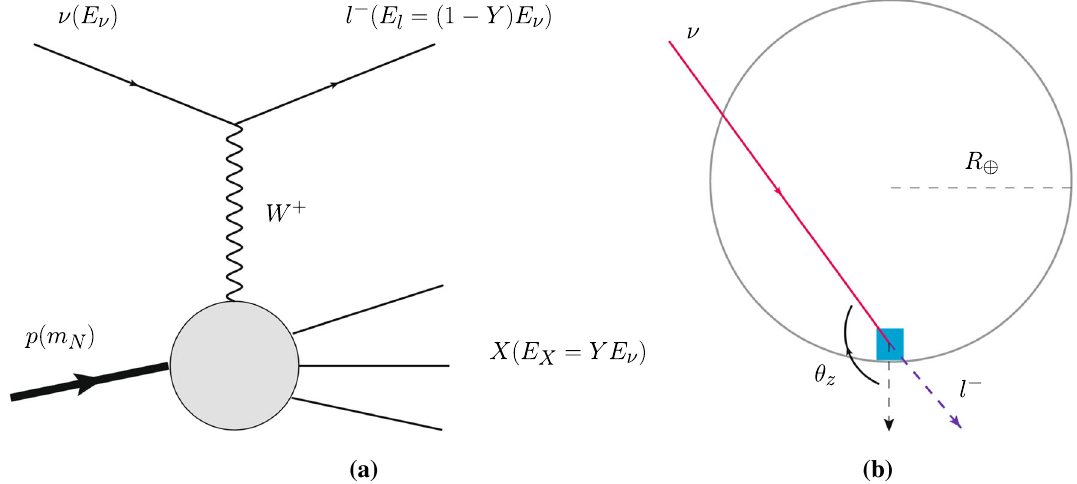
Fig. 1 a Deep inelastic neutrino-hadron scattering mediated by a W exchange in the target rest frame; b representation of the neutrino propagation through the